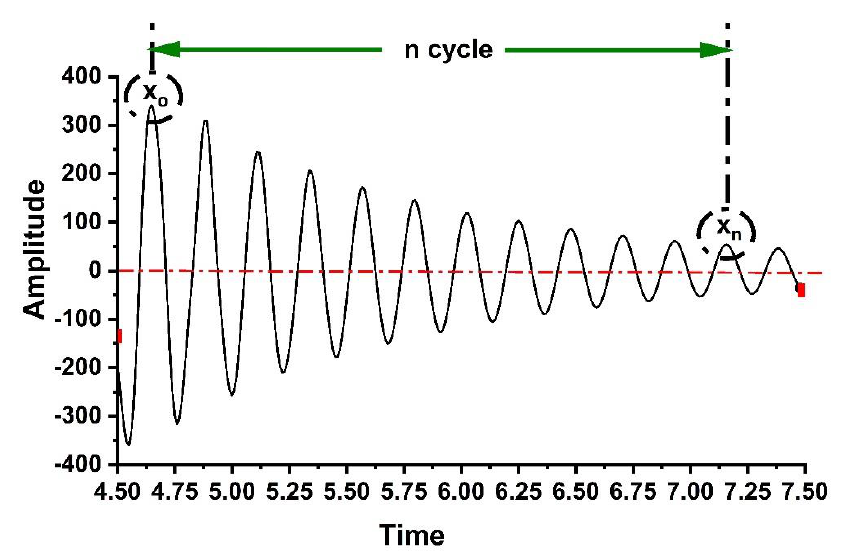
Figure 2. Schematic drawing of the free vibration impact test.